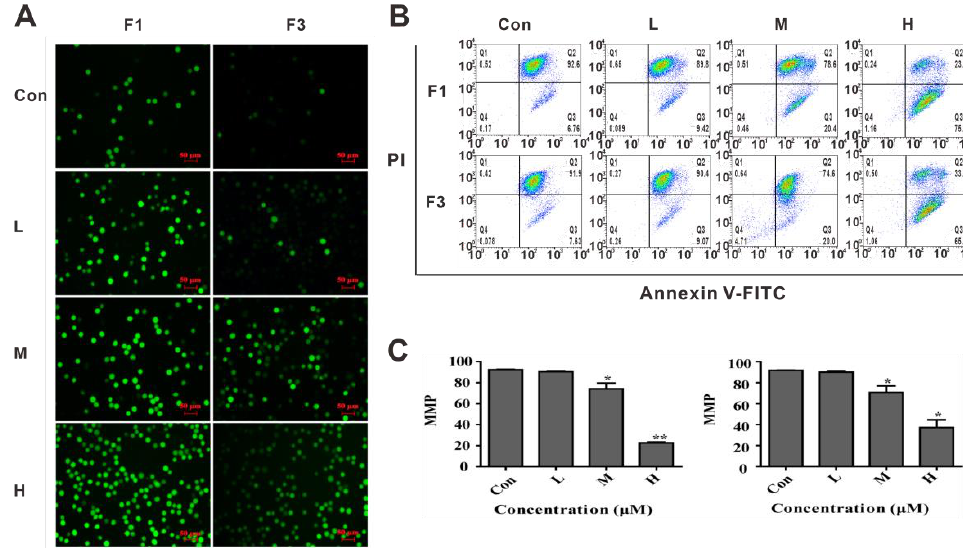
Figure 3. F1 and F3 induced ROS production and contributed to the MMP decrease in Jurkat cells. ( A )The level of ROS in Jurkat cells was observed by fluorescence microscope after treated with F1 or F3 for 48 h at different concentrations (Scale bar =50 µm, 200×). ( B , C ) Changes in the MMP levels in Jurkat cells after treated with F1 or F3 at different concentrations were determined by flow cytometer. The shift-down of fluorescence from FL-2 (red fluorescence) to FL-1 (green fluorescence) indicated the collapse of MMP. Data were presented as mean ± SEM of three independent experiments; * p < 0.05 and ** p < 0.01 vs. the control group.